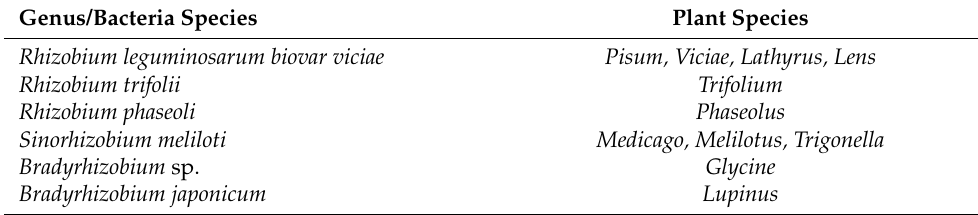
Table 1. The basic symbiotic pairs in agriculture [50–52]. Genus/Bacteria